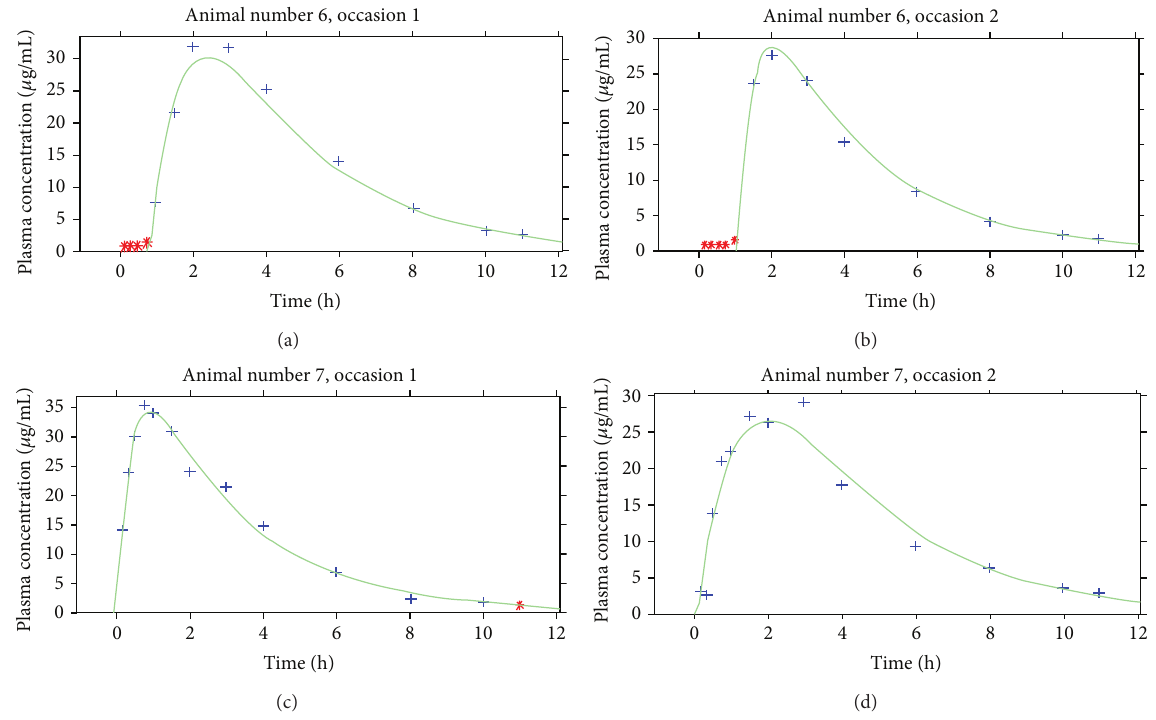
Figure 1: Concentration versus time profiles of cephalexin. Symbols represent the observed data for two representative animals studied in two occasions: green line, individual